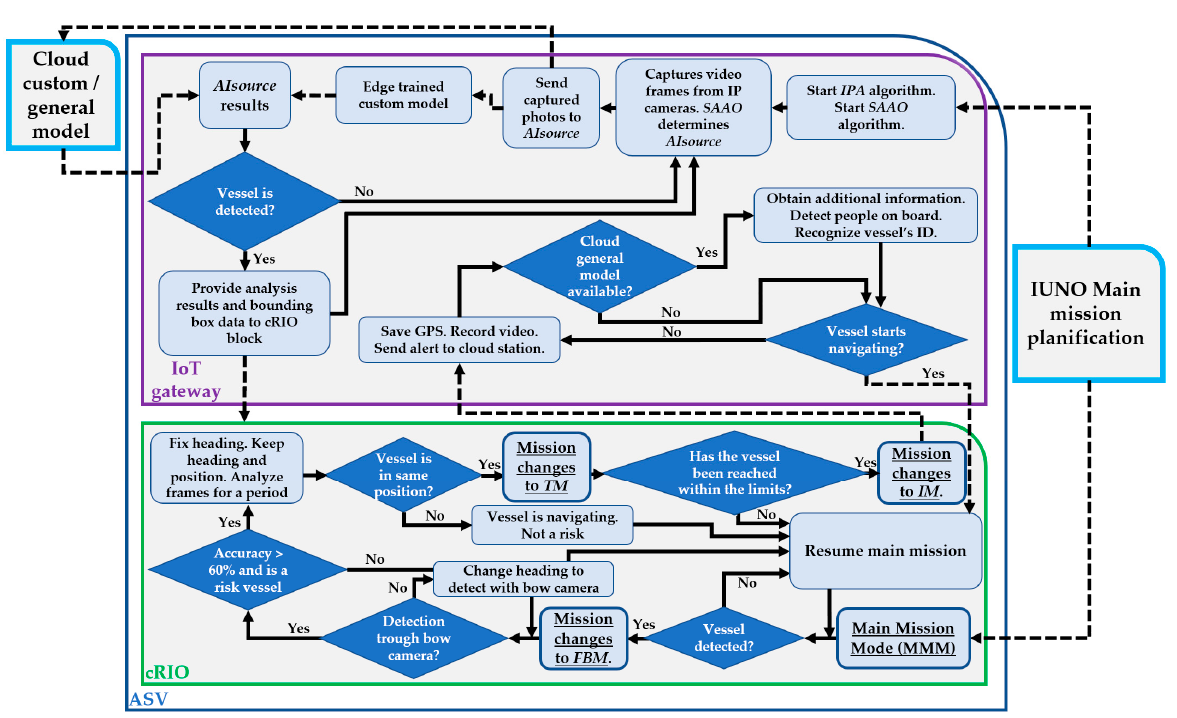
Figure 3. Platform’s communications in the tracking algorithm. IPA—Image processing algorithm.